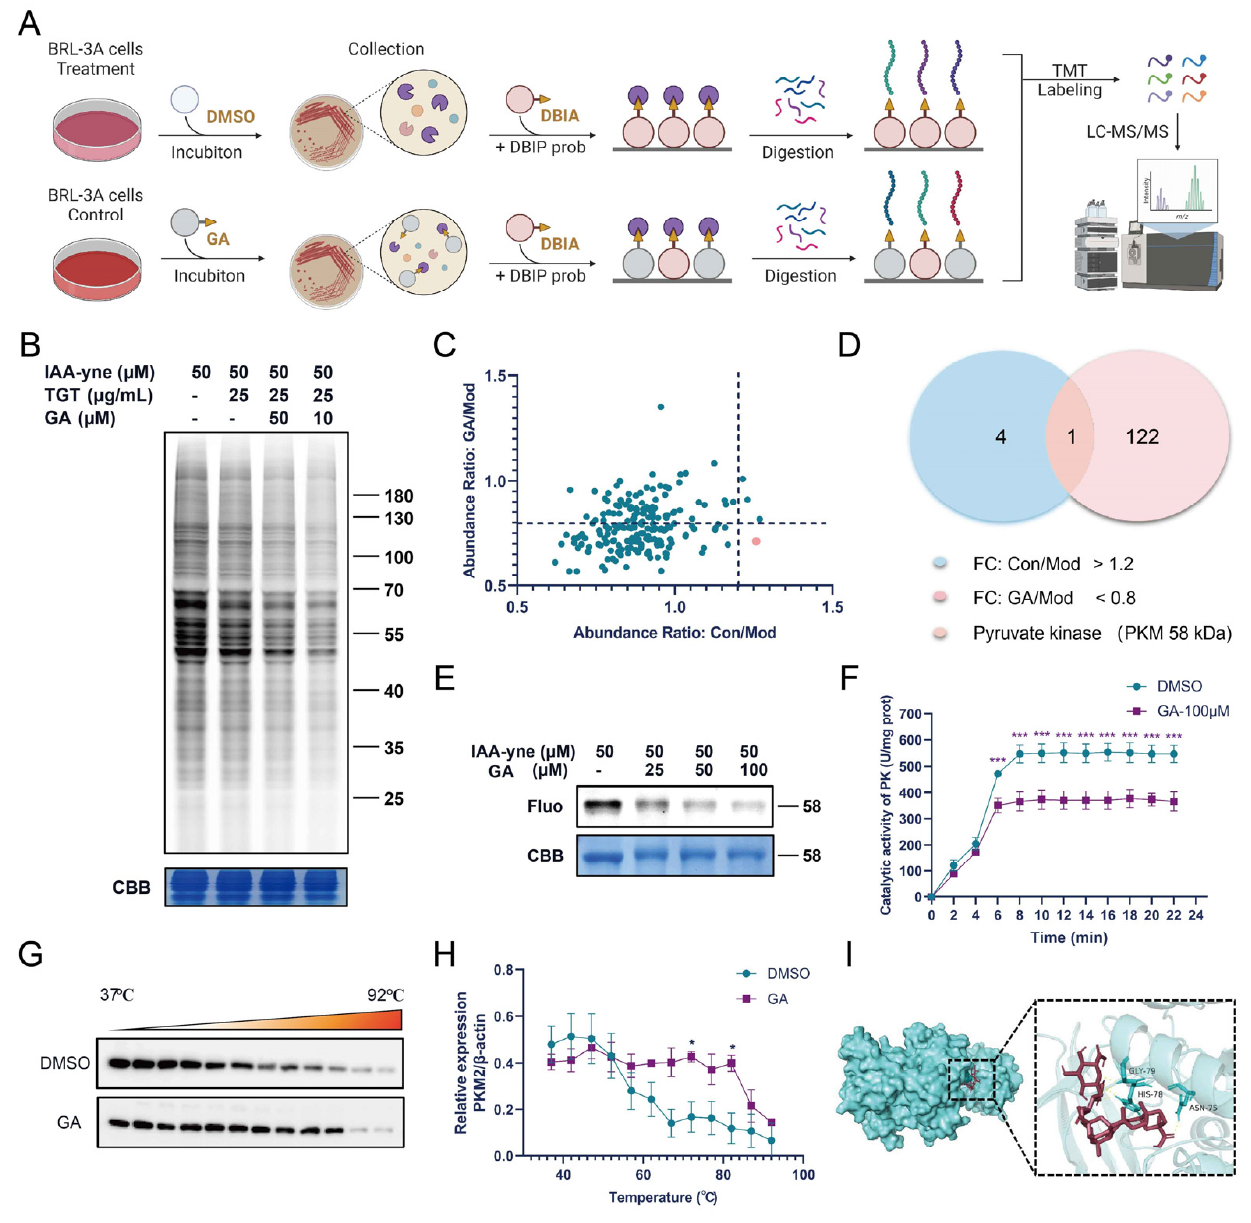
Figure 4. Identification of potential targets of GA in vitro. ( A ) Overall flow of ABPP analysis of GA targets; ( B ) the competition between proteins labeled with 50 µ M IAA-yne probe by GA in situ; ( C , D ) competitive effects of GA on the binding of PKM to IAA-yne probe by LC-MS/MS analysis; ( E ) GA competes with IAA-yne for binding to purified recombinant PKM2 protein in the in-gel fluorescence assay; ( F ) changes in PK with or without GA treatment, n = 3, *** p < 0.001 vs. DMSO; ( G , H ) CETSA-WB verification of GA binding to PKM2, n = 3, * p < 0.05 vs. DMSO; ( I ) molecular docking simulation of GA binding to PKM2 protein.